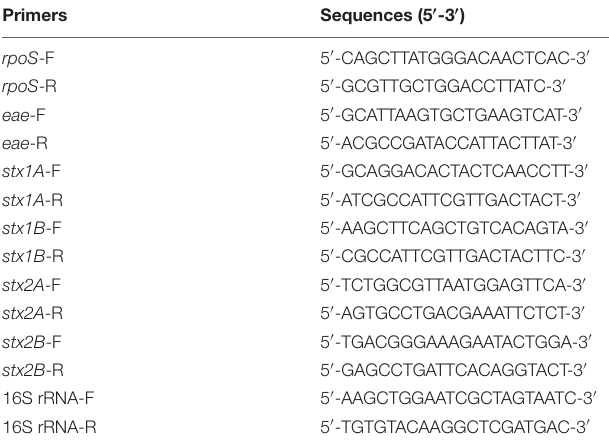
TABLE 2 | Primers used in